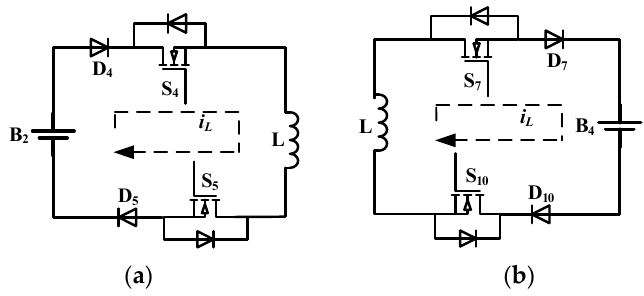
Figure 5. The equalization process of a bottom layer equalization circuit. ( a ) Charge L, ( b ) discharge L.